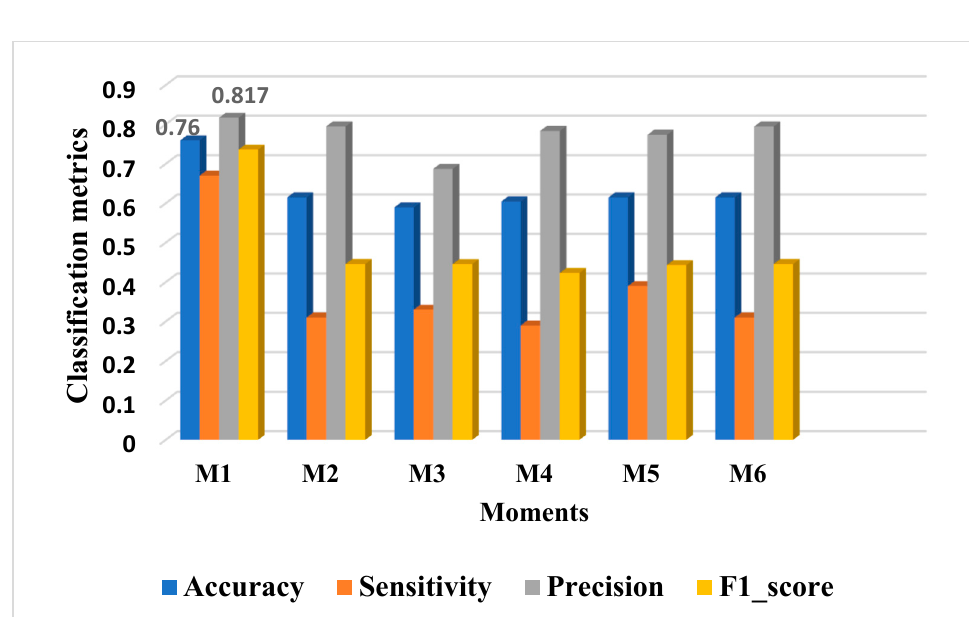
Figure 4. Classification performance of RBFNN from BUSI database.